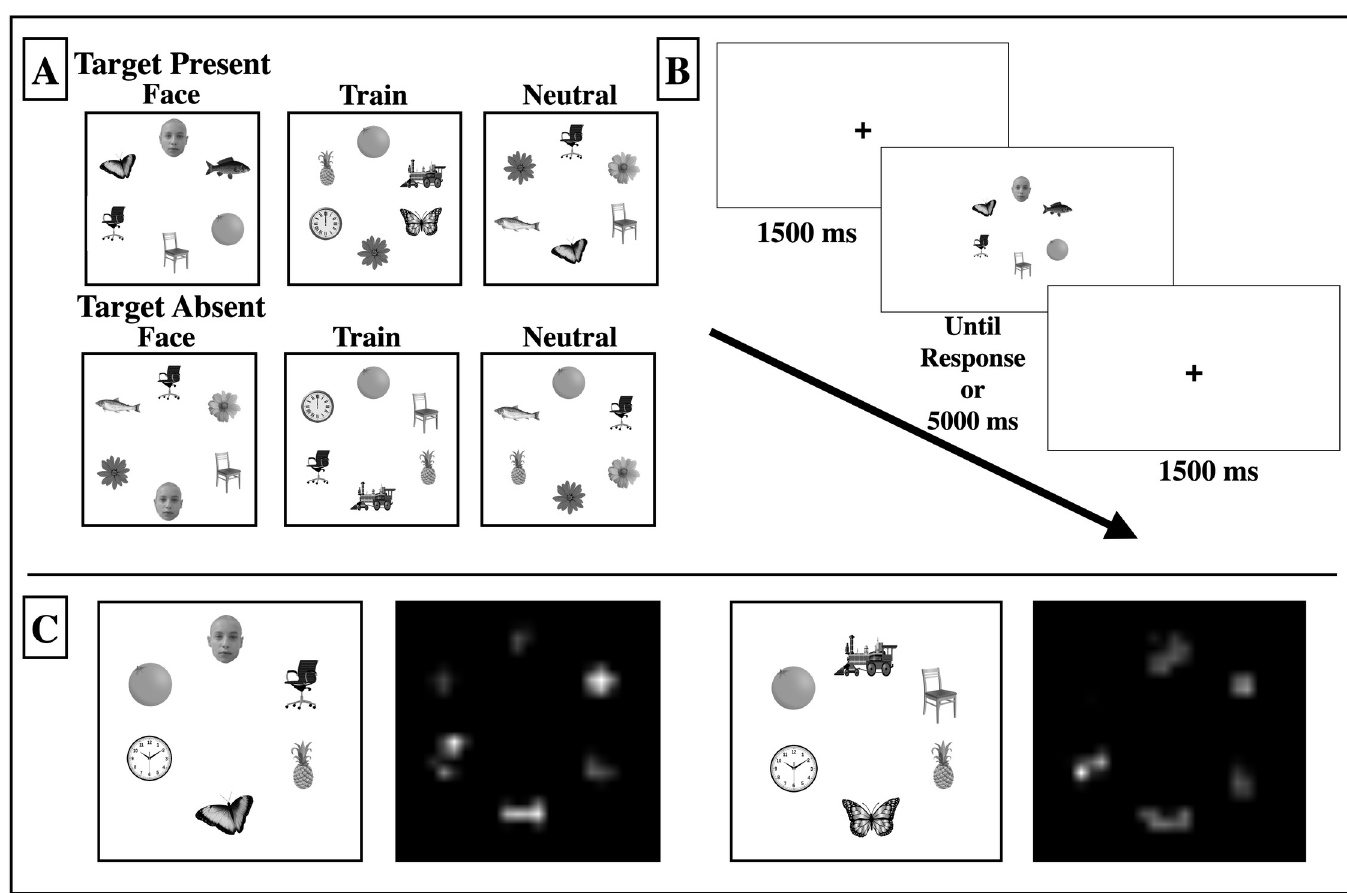
Fig 1. Experimental setup. A: Participants viewed an array of 8 grey-scale objects on a white background. Target present arrays contained a butterfly stimulus, while face and train arrays contained critical face and train distractors. The remaining objects occupying the arrays were classified as neutral stimuli (i.e. fruit, flower, chair, clock, and fish stimuli). B: On each trial a fixation cross appeared in the centre of the screen for 1500 ms. A stimulus array was then presented and participants were instructed to indicate as quickly and accurately as possible whether a butterfly target was present. Search displays remained on screen until participants made a keypress or until 5000 ms had elapsed. C: Sample visual saliency maps generated using Saliency Toolbox [55,56] in Matlab; to remain consistent with other users of this toolbox we used all default parameters (Iterative Normalization). Note: due to copyright restrictions, many of the images in this figure are representative. See S1 File for information on how to access the actual images used in the